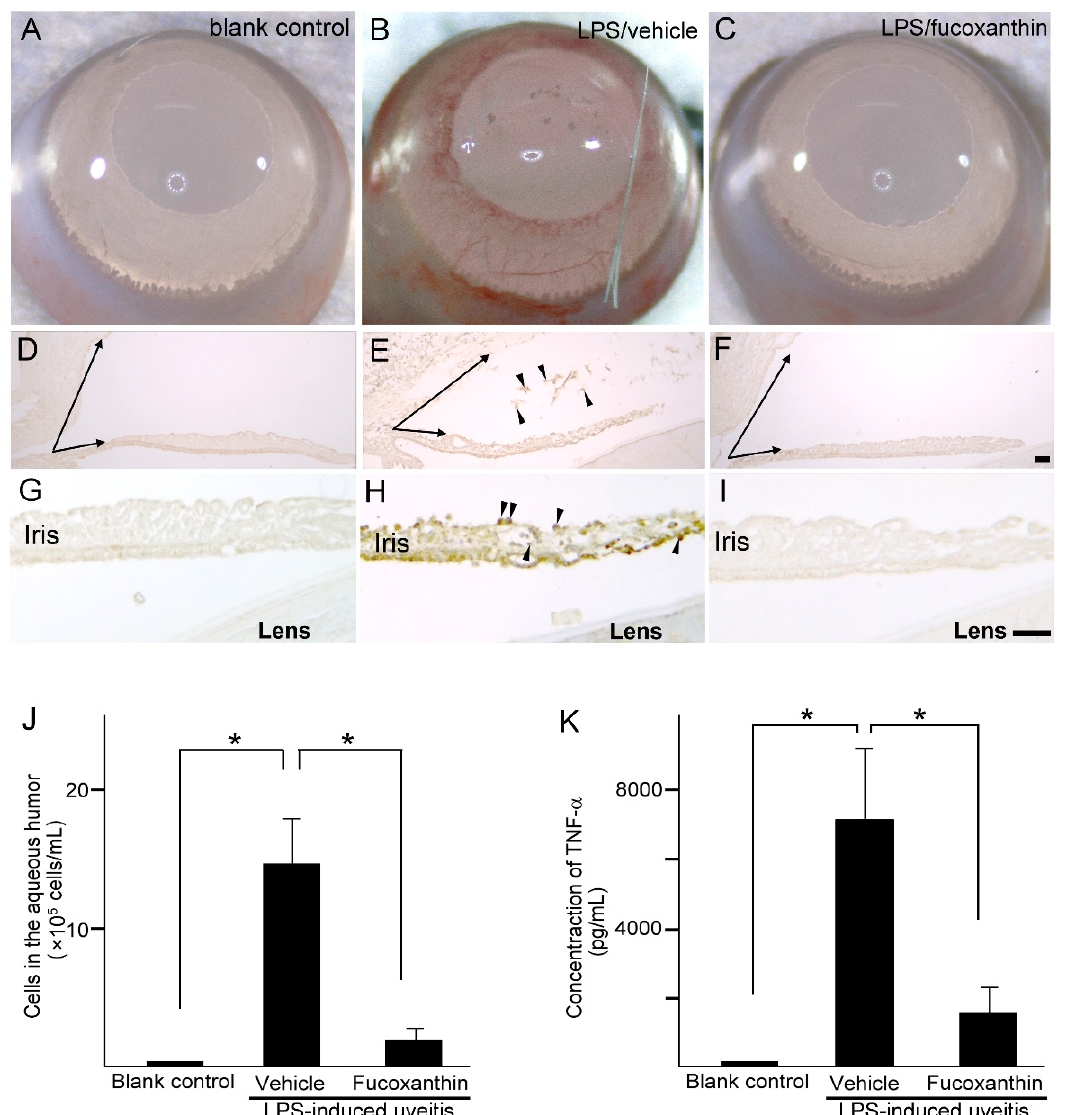
Figure 4. Effects of fucoxanthin on iris hyperemia, inflammatory cells, and TNF- α protein concentrations. Compared to the blank control group ( A ), iris hyperemia was observed in the LPS/vehicle group ( B ). These signs were alleviated in the LPS/10 mg/kg BW of fucoxanthin group ( C ). Moreover, the abundance of inflammatory cells was evaluated by immunohistochemical analysis of MPO-positive leukocytes in the blank control ( D , G ), LPS/vehicle ( E , H ), and LPS/fucoxanthin ( F , I ) groups. A narrowed anterior chamber angle and number of MPO-positive leukocytes (arrow- heads) in the aqueous humor ( E ) and iris ( H ) were found in the LPS/vehicle group compared to the control group ( D , G ). In contrast, a relatively wider anterior chamber angle and a decreased number of MPO-positive leukocytes were observed in the aqueous humor ( F ) and iris ( I ) of the LPS/fucoxanthin group compared to that of the LPS/vehicle group. In addition, the aqueous hu- mor was collected to count the number of cells ( J ) and to measure the expression levels of the in- flammatory cytokine TNF- α ( K ). The cell count and TNF- α expression levels were increased in the LPS/vehicle group, whereas the number of inflammatory cells and the TNF- α levels in the fuco- xanthin-treated groups were significantly decreased. The results are presented as the mean ± SD ( n = 5). * p < 0.05: Compared to the LPS/vehicle group (Student’s t -test). Scale bars: 100 μ m. 3.5. Effect of Fucoxanthin on the PAMP LPS-Induced Impaired Pupillary Light Reflex and Autonomic Denervation of Iridial Tissues This pupillary light test can be used to diagnose parasympathetic denervation of the pupillary sphincter muscle. To assess denervation in the area of the sphincter muscles of the iris, the initial noticeable symptom of autonomic impairment is a reduction in the am- plitude of pupillary constriction to light. In the present study, the pupillary light reflex was affected by LPS treatment. After LPS treatment, the harshness of pupil abnormalities